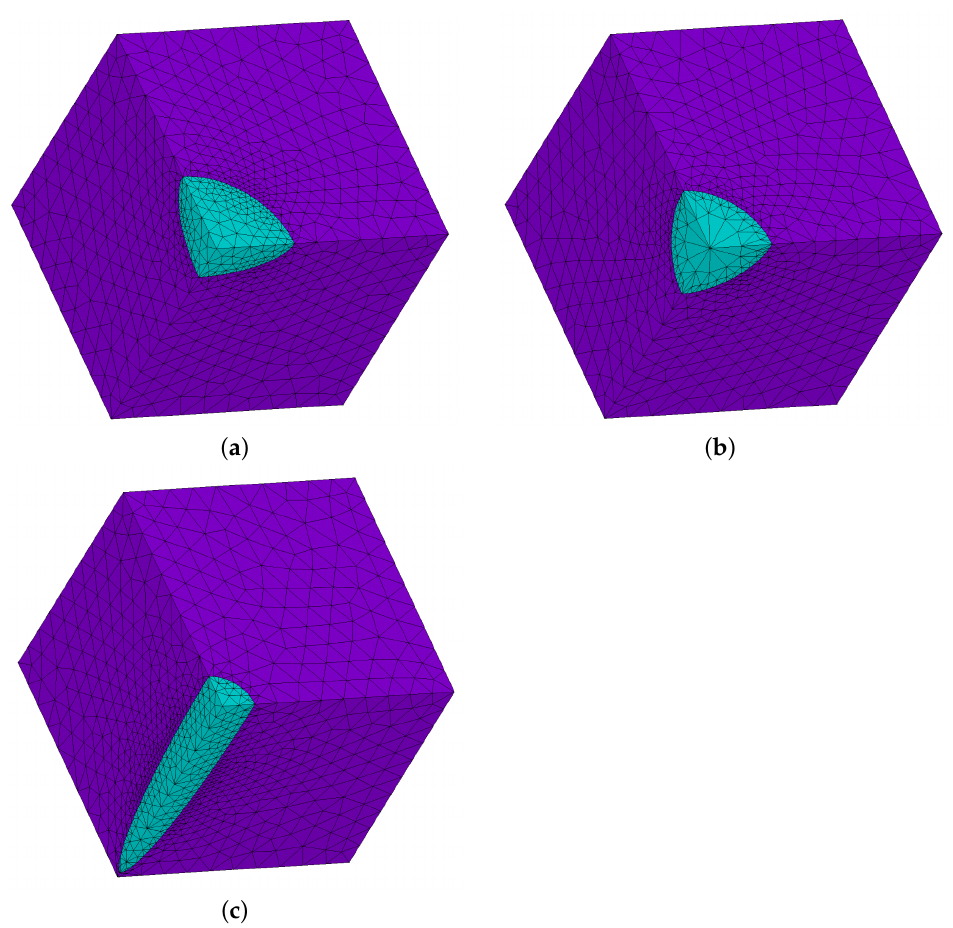
Figure 2. Discretization for one-eighth of the periodic cells using ANSYS (Solid187 element) for different inclusion shapes: ( a ) discs, ( b ) spheres and ( c ) ellipsoids.